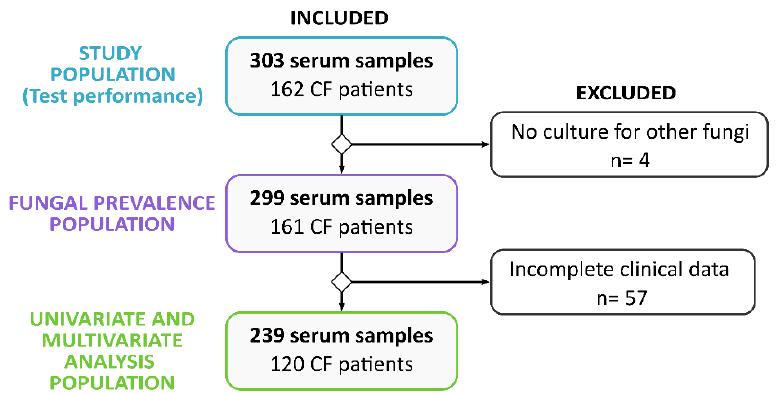
Figure 1. Flow diagram for study population. Dataset employed in each stage of the project ( left ): total population for test performance, for fungal prevalence calculation and for univariate/multivariate analysis. Samples excluded from evaluable dataset and reasons for exclusion ( right ).